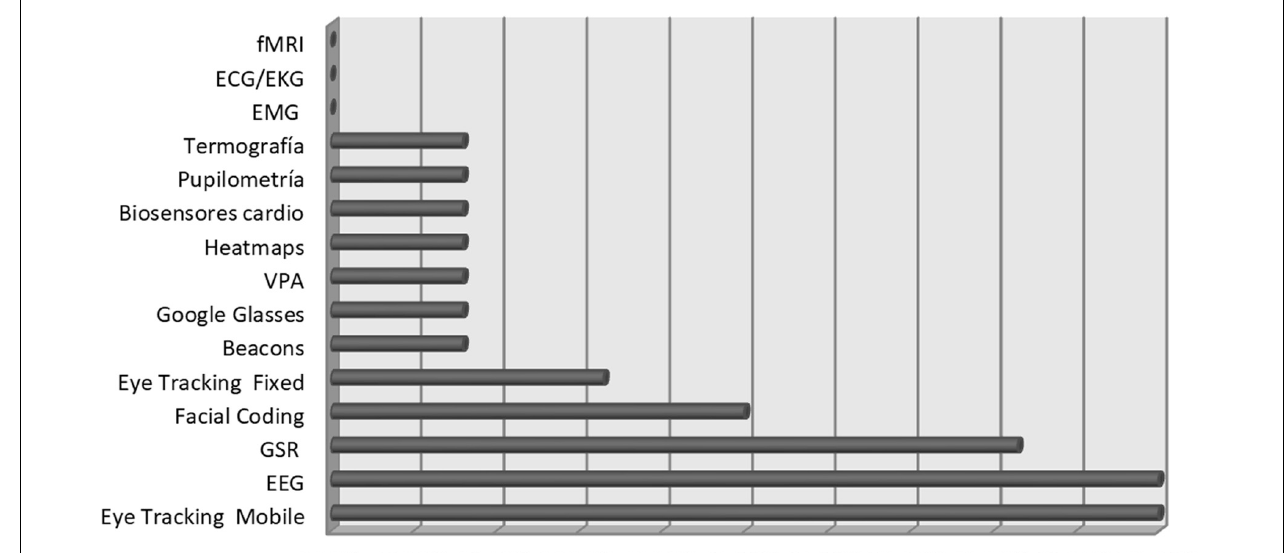
FIGURE 1 | Consulting companies